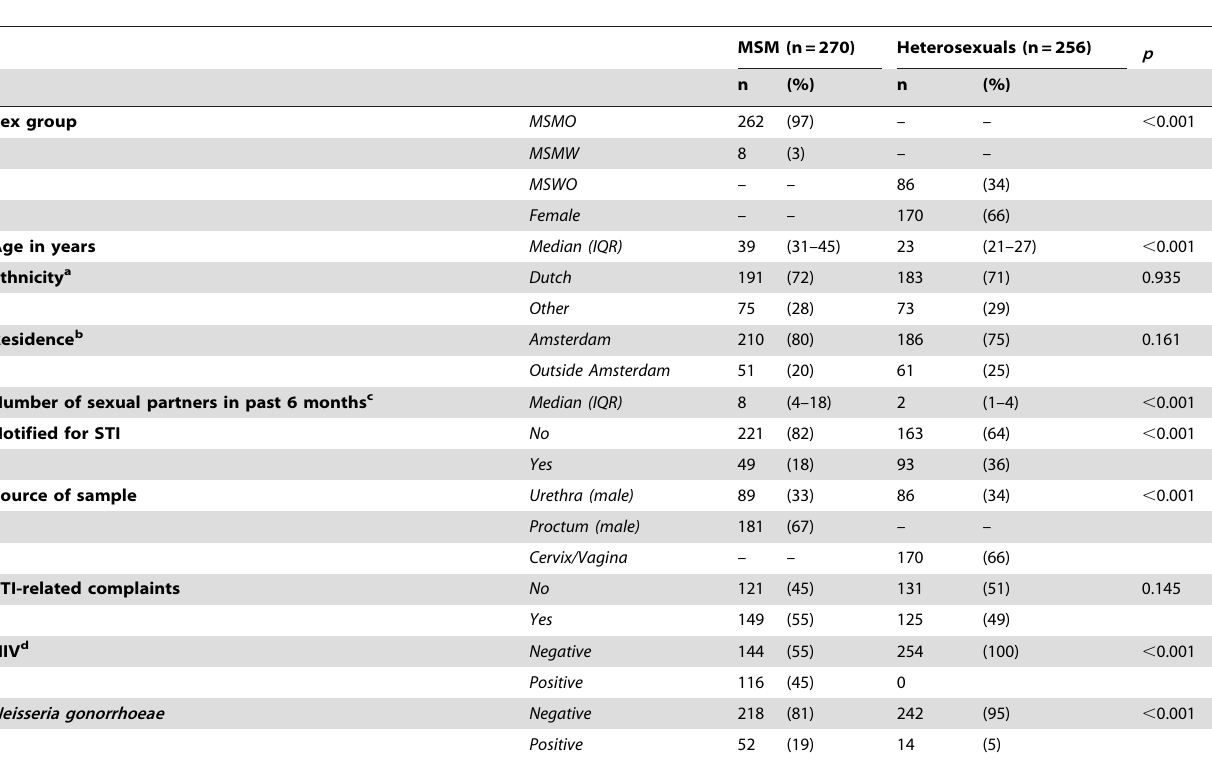
Table 1. Demographic and clinical characteristics of MSM and heterosexuals with Chlamydia trachomatis infection, STI outpatient clinic, Amsterdam, July 2008–May